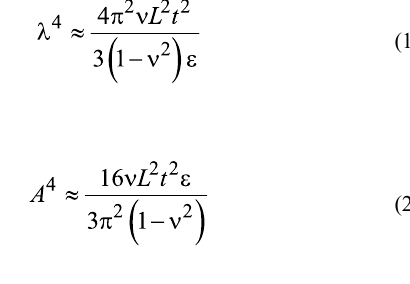
kles in MLG are wider apart or closer together at different loca- tions. As MLG does not store sufficient elastic strain energy, wrinkling is irreversible but it can be altered by external influ- ences [16]. The surface roughness varies owing to the different topographical features such as size and shape of the wrinkles. Therefore, the ability of sheets to mechanically interlock with other sheets and polymer chains varies. Wang et al. showed that wavelength and amplitude of wrinkles are directly proportional to the volumetric dimensions of the graphene sheets as described in Equation 1 and Equation 2, where λ is the wrinkle wavelength, ν is Poisson’s ratio, L is the graphene sheet size, t is the thickness of the graphene sheet, ε is edge contrac- tion on a suspended graphene sheet, and A is the wrinkle amplitude